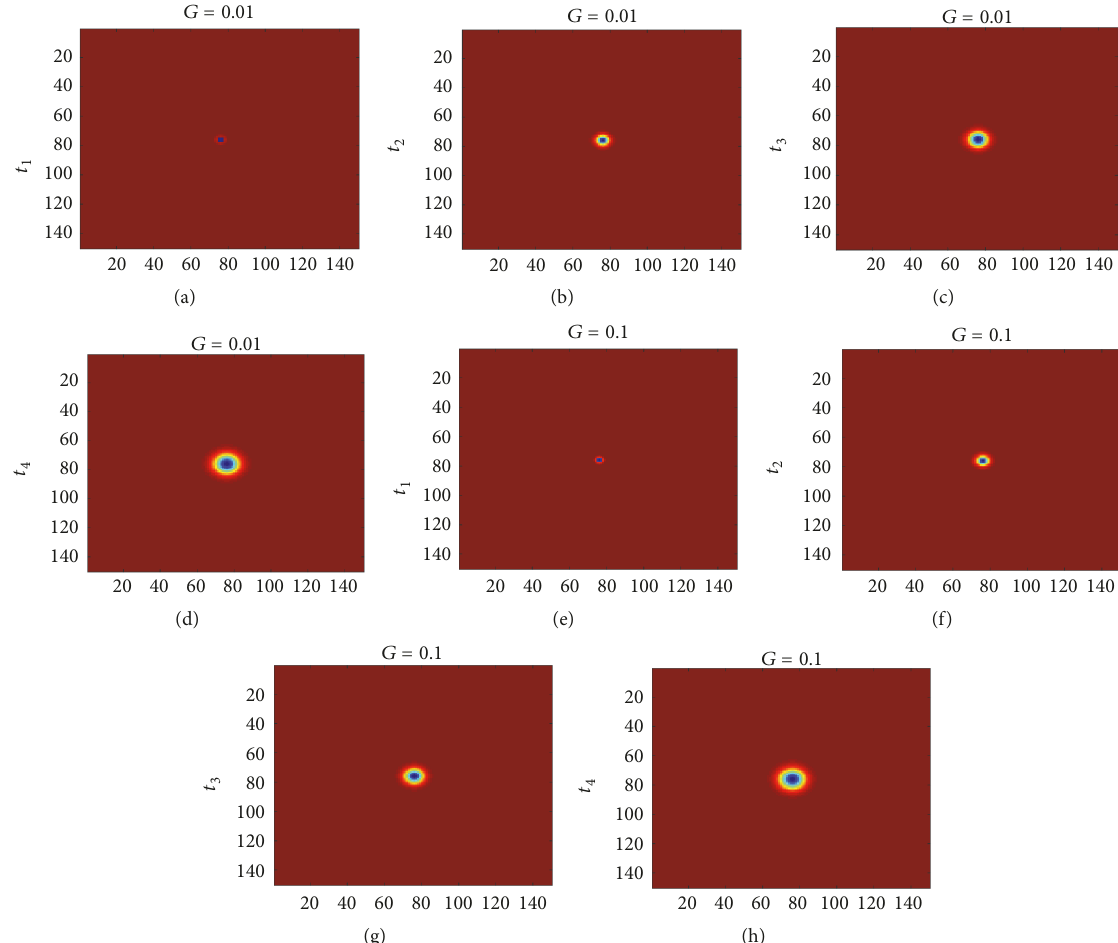
Figure 21: The snapshots of spatial distribution of membrane potential with color scale for neurons in the square array network for 𝑘 = 1.5 and 𝐷 = 1 at 𝑡 1 = 2 time units, 𝑡 2 = 75 time units, 𝑡 3 = 170 time units, and 𝑡 4 = 300 time units. ((a)–(d)) 𝐺 = 0.01 and ((e)–(h)) 𝐺 = 0.1 .